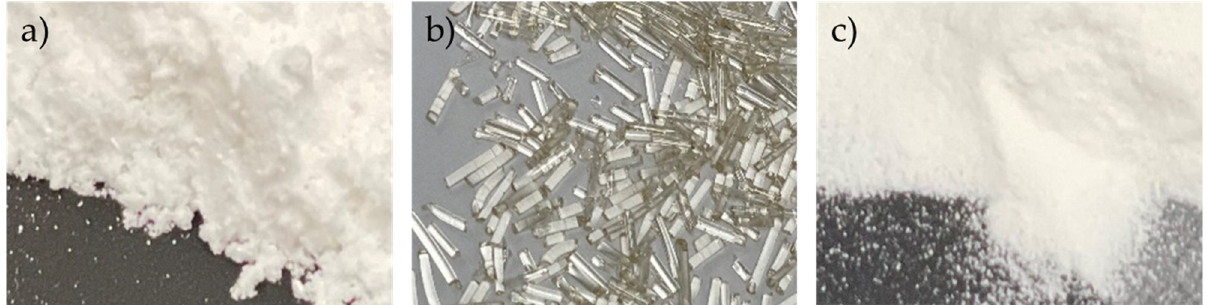
Figure 1. Photographs of ( a ) ITZ-KOL-PM, ( b ) ITZ-KOL-ASD extrudate pellets and ( c ) milled ITZ- KOL-ASD, for comparison purposes.